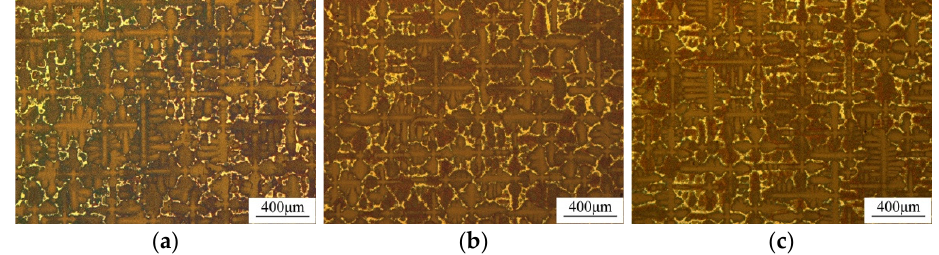
Figure 2. As-cast dendritic microstructure of the alloy with different Co contents: ( a ) 6% Co; ( b ) 9% Co and ( c ) 12% Co.